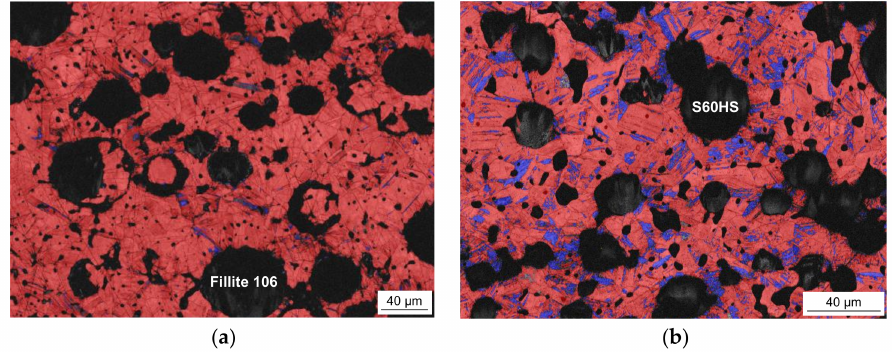
Figure 14. EBSD phase maps for two selected TRIP-steel syntactic foams deformed up to 10% strain under quasi-static compression: ( a ) T4C and ( b ) T4G; red—austenite (fcc), blue— α (cid:48) -martensite (bcc), grey/black—not indexed, ε -martensite was